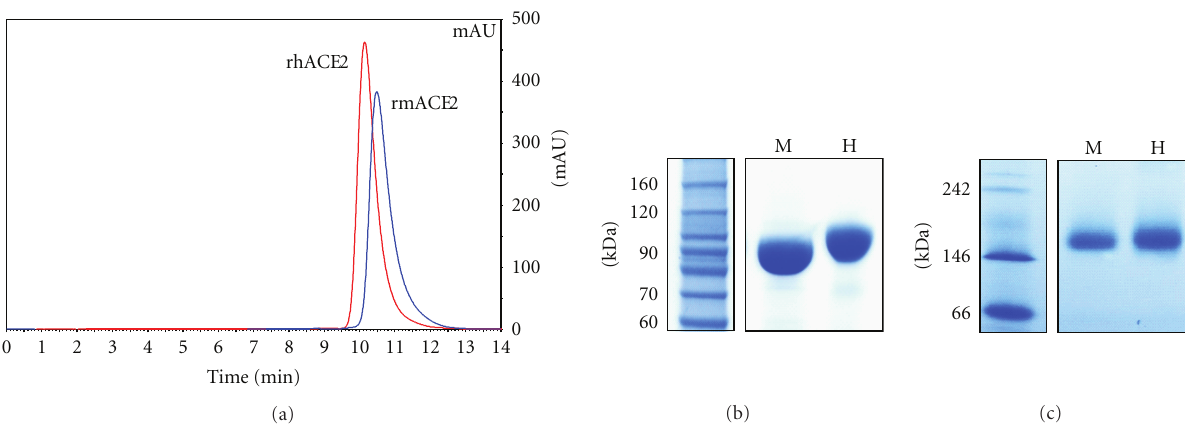
Figure 1: Batch quality of recombinant human and murine ACE2. (a) Equal amounts (5 μ g) rmACE2 and rhACE2 were analyzed by size- exclusion chromatography. The elution was continuously monitored by in-line measurement of the absorbance at 280nm. The eluted peaks for purified rmACE2 (blue) and rhACE2 (red) are shown in the chromatogram and given in absorption units (mAU). (b) Equal amounts (7 μ g) of rmACE2 (m) and rhACE2 (h) were subjected to SDS-PAGE analysis followed by in-gel protein staining with Coomassie Brilliant Blue. Selected marker bands are depicted in the graph to allow the estimationof molecular weights. (c) Equal amounts (2 μ g) of rmACE2 (m) and rhACE2 (h) were analyzed in native PAGE followed by in-gel protein staining with Coomassie Brillant Blue as described in Section